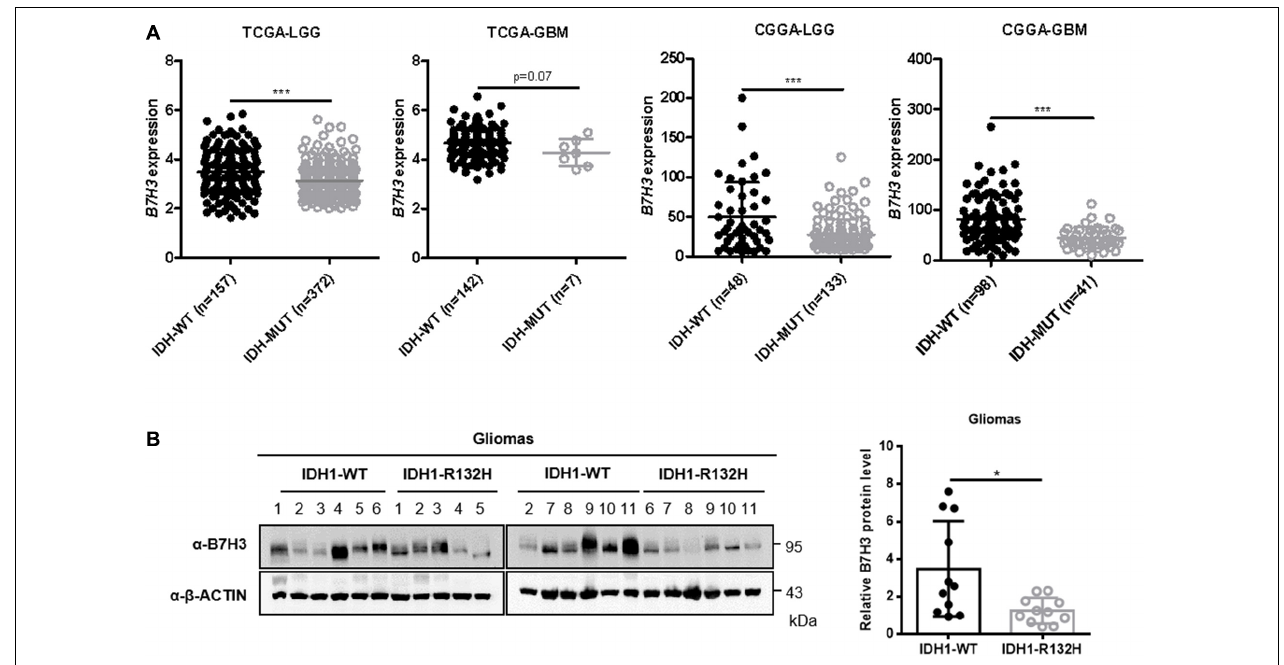
FIGURE 1 | B7H3 is downregulated in IDH-mutated gliomas. (A) B7H3 mRNA expression is significantly decreased in IDH-mutated gliomas according to the TCGA and CGGA datasets. Gliomas from the TCGA and CGGA databases was separated into lower-grade glioma (LGG) and GBM subgroups, respectively. In the TCGA-LGG subtype, n = 157 in IDH-WT and n = 372 in IDH-MUT groups, respectively, in the TCGA-GBM subtype, n = 142 in IDH-WT and n = 7 in IDH-MUT groups, respectively, in the CGGA-LGG subtype, n = 48 in IDH-WT and n = 133 in IDH-MUT groups, respectively, and in the CGGA-GBM subtype, n = 98 in IDH-WT and n = 41 in IDH-MUT groups, respectively. MUT = mutant. ***denotes the P < 0.001 for the indicated comparisons. (B) B7H3 protein level is significantly reduced in IDH1-R132H glioma specimens. IDH1-WT and IDH1-R132H fresh human glioma specimens ( n = 11 per group) were collected, and B7H3 protein level was detected by immunoblotting using the indicated antibodies (left). Quantification of the protein level of B7H3 was shown on the right. *denotes the P < 0.05 for the indicated comparison.